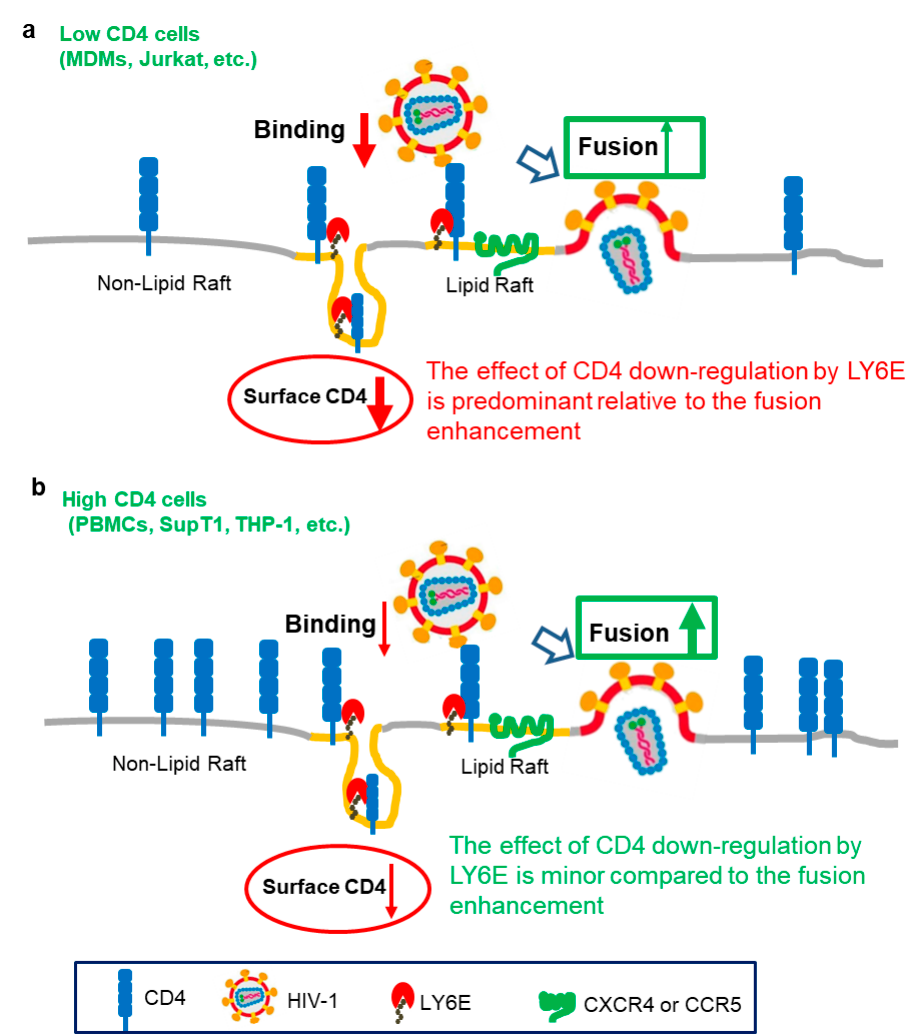
Figure 1. Working model for the differential effects of LY6E on HIV-1 infection. Adapted from Yu et